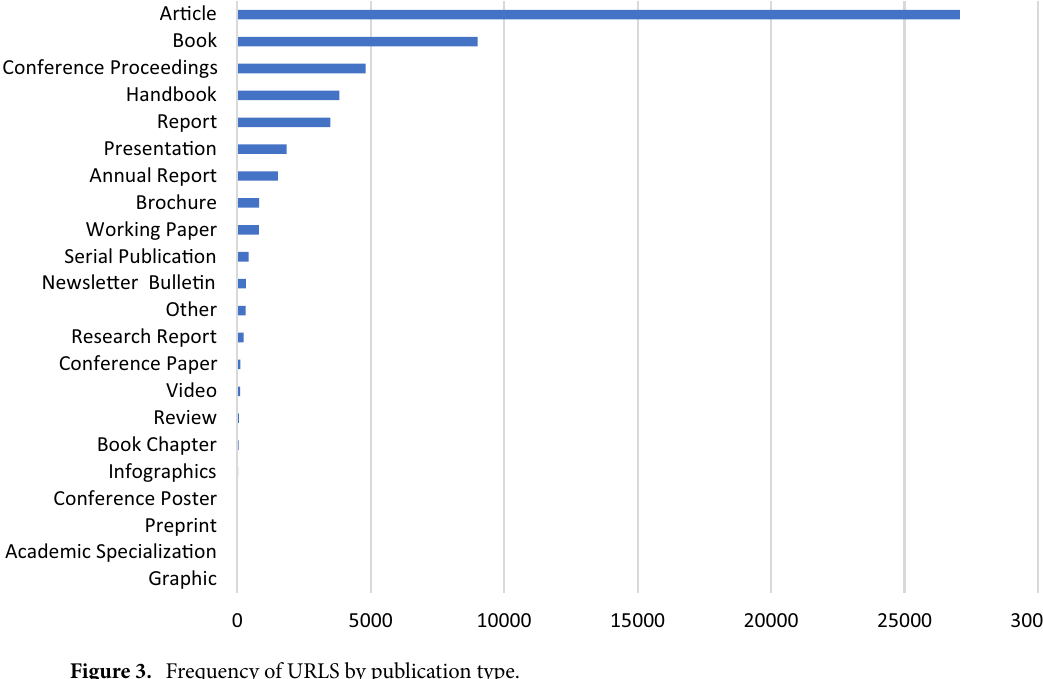
Figure 3. Frequency of URLS by publication